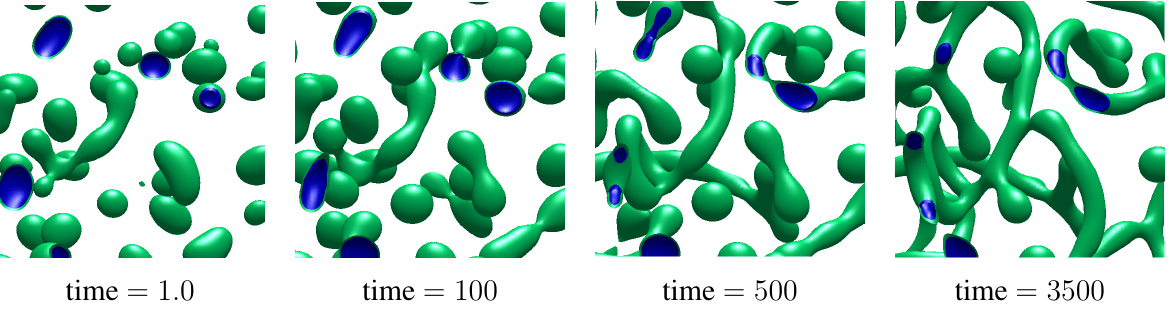
Figure 3. Two level sets of u evolving under gradient flow, Equation (6), from random initial data with a 15% solvent volume fraction, τ = The solvent accumulates into micellular structures which merge and then elongate into end-capped dumb-bell structures that subsequently merge into a pore network with several Y junctions.